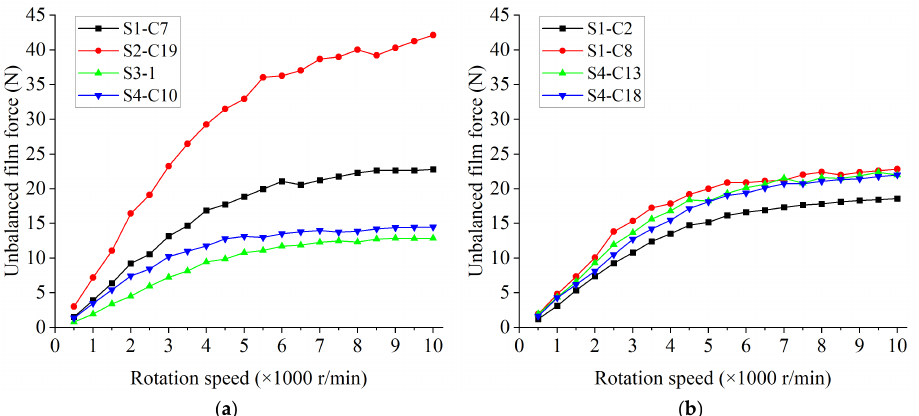
Figure 16. Unbalanced gas film force of ideal shaft: ( a ) ideal shaft with similar roundness; ( b ) ideal shaft with similar discrete